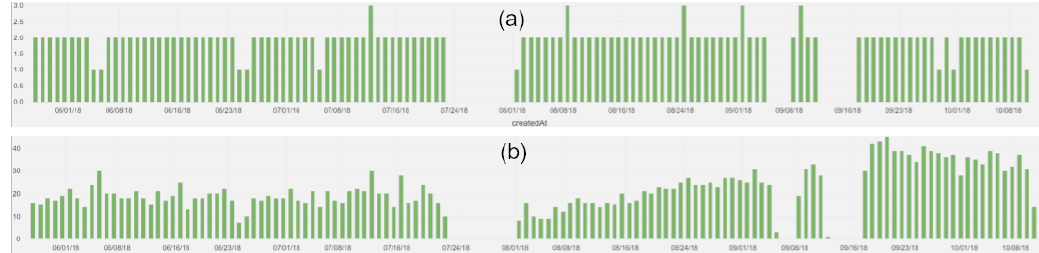
Figure 9. Comparing bot-behaviour observed within the Twitter dataset with typical manual behaviour. ( a ) Webversity, ( b )